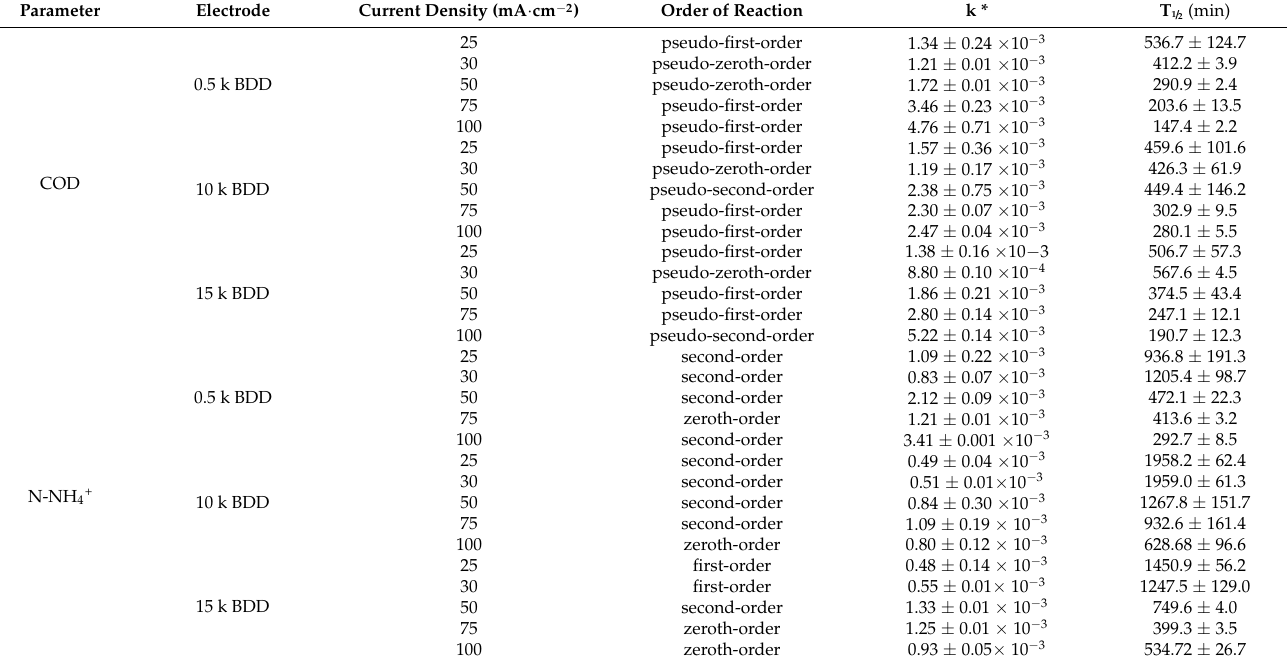
Table 3. Electrochemical degradation kinetics for COD and N-NH 4+ in LLs with different j and different electrodes used. Parameter